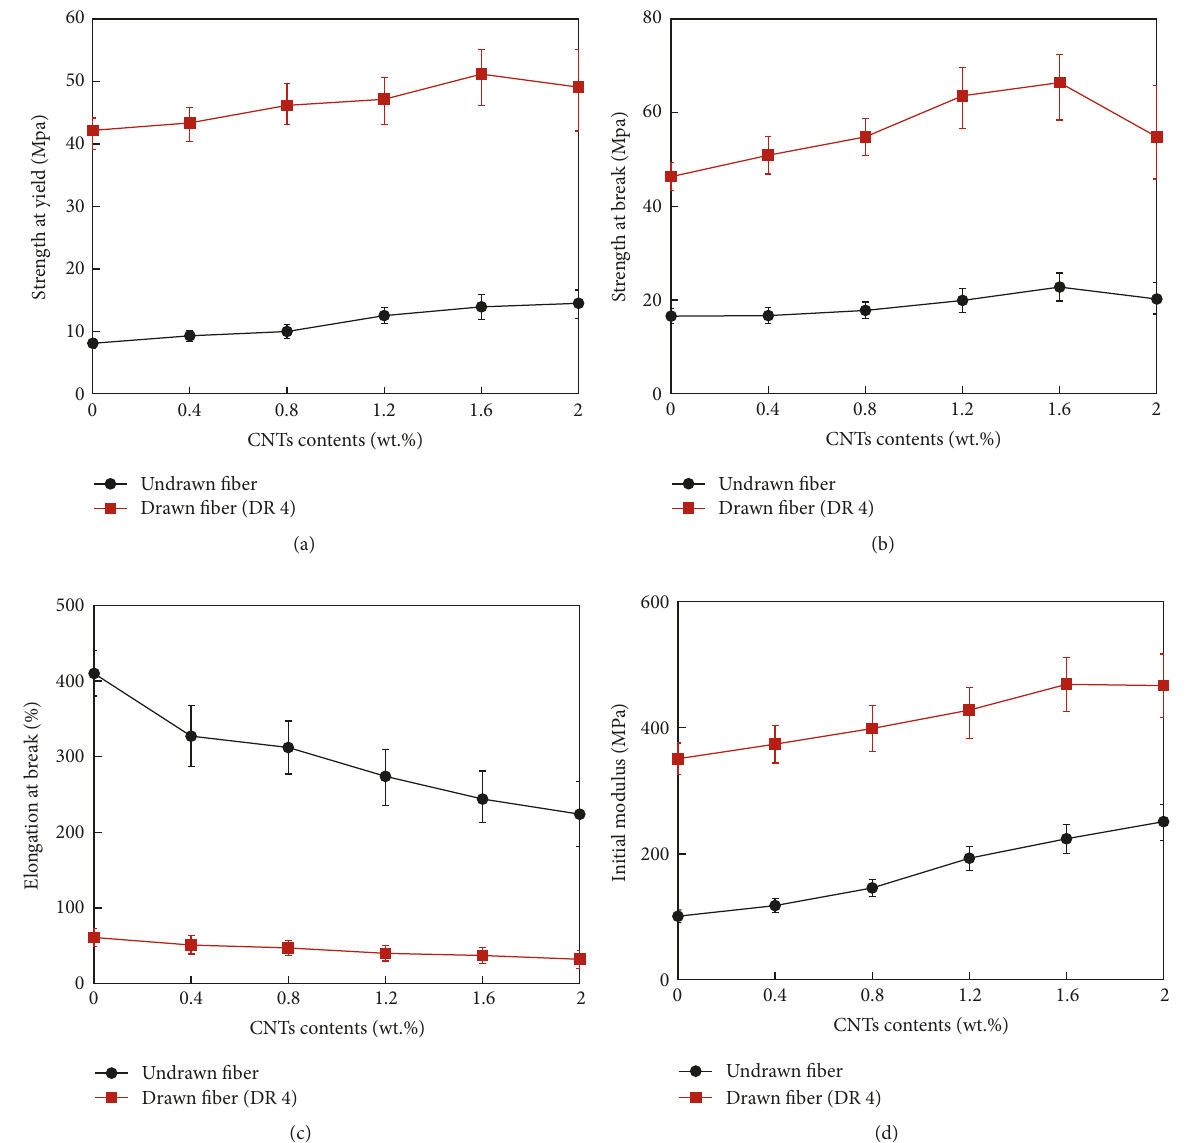
Figure 4: Tensile property of undrawn and drawn LLDPE fiber as a function of CNTs contents: (a) strength at yield; (b) strength at break; (c) elongation at break; and (d) initial